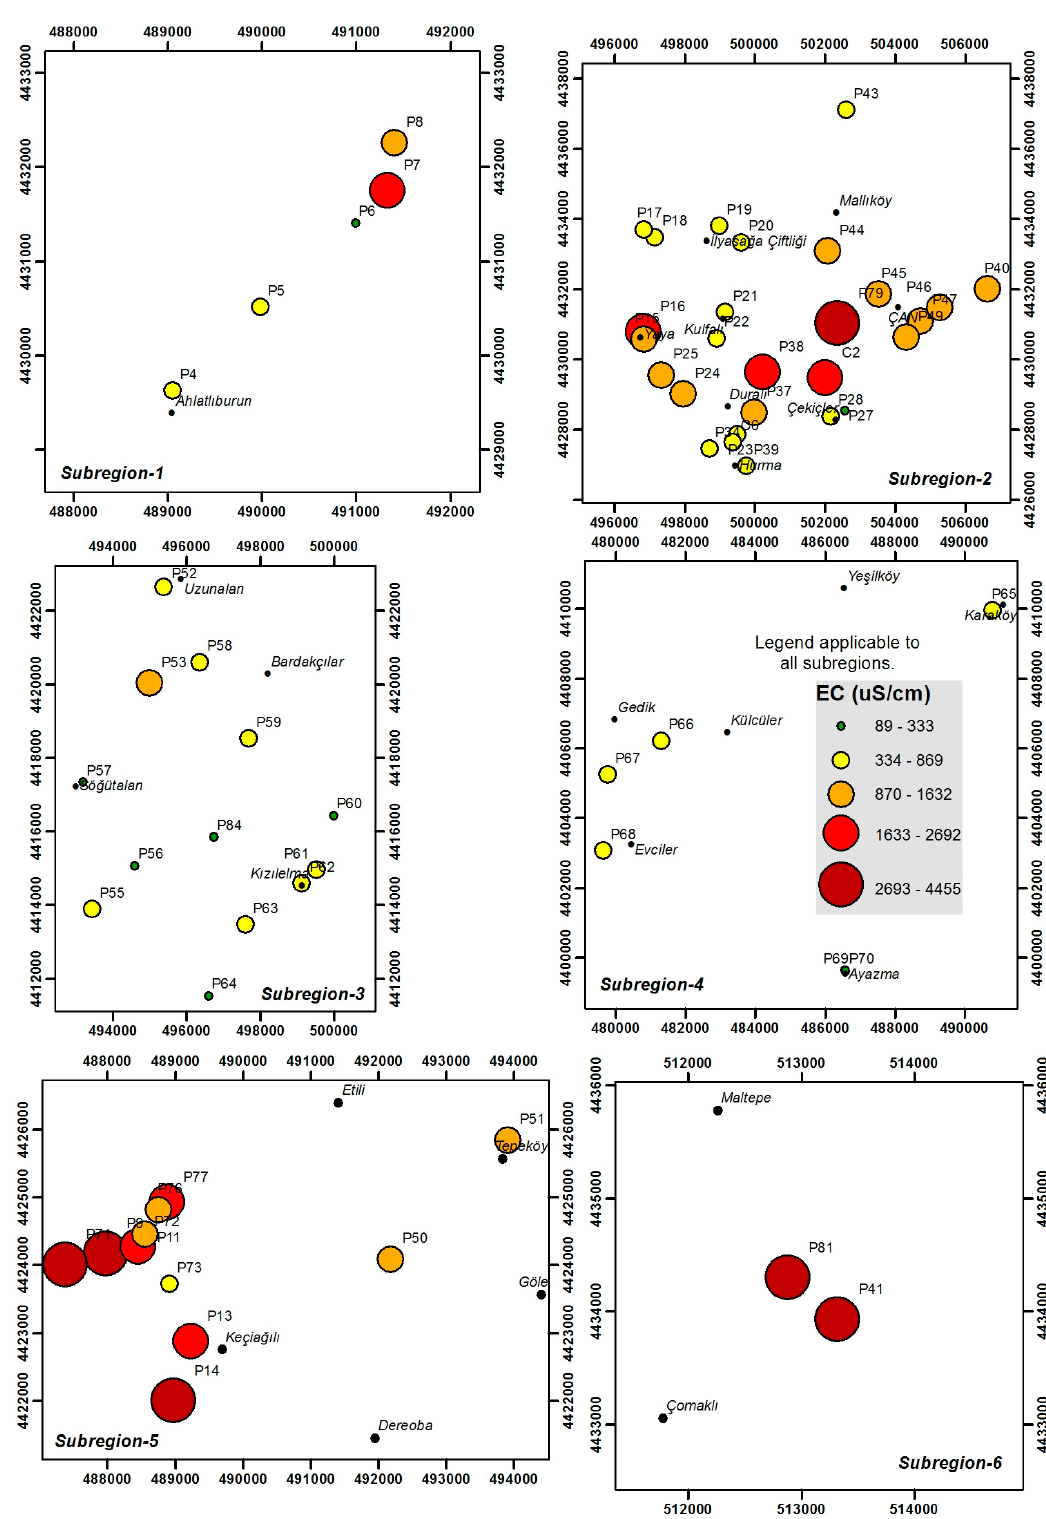
Figure 5. Spatial distribution of electrical conductivity.